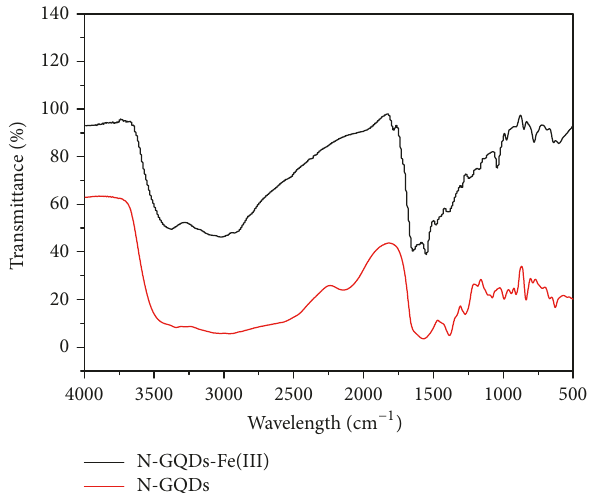
Figure 3: FT-IR diagrams of N-GQDs prepared by citric acid: ethylenediamine=1:3 and N-GQDs-Fe 3+ .